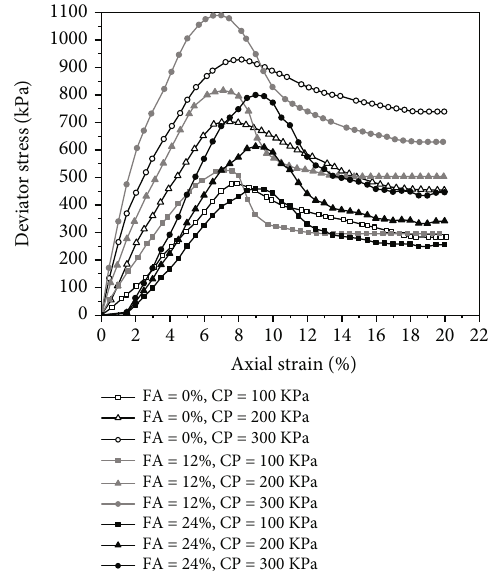
Figure 15: Stress-strain curves ( FT = 60 , L = 12 %